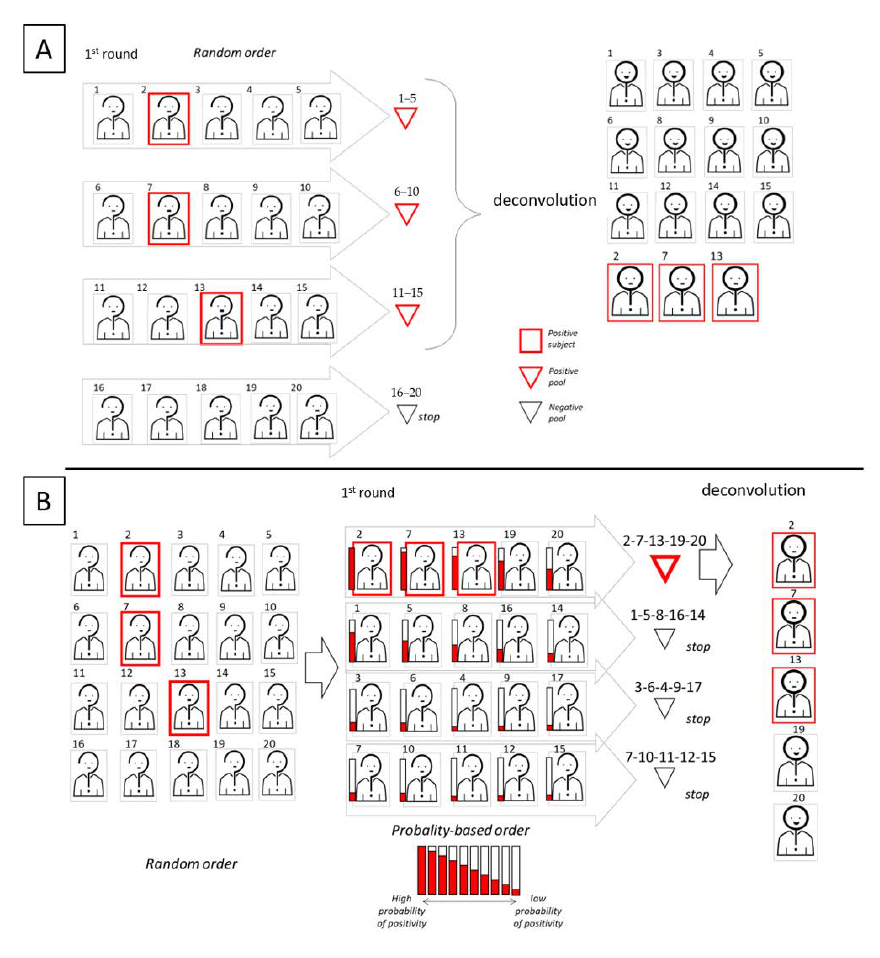
Figure 6. Graphic representation of the informed sequential pooling approach. In this example, the cohort dimension is 20, the pool size is 5. Upper ( A ) and lower ( B ) panels show two possible scenarios based on available information allowing for the classification of subjects as either “suspect positive” or “suspect negative.” In scenario B, information allows for a concentration of all the positive subjects in the same pool and so improve the efficiency of the pooling